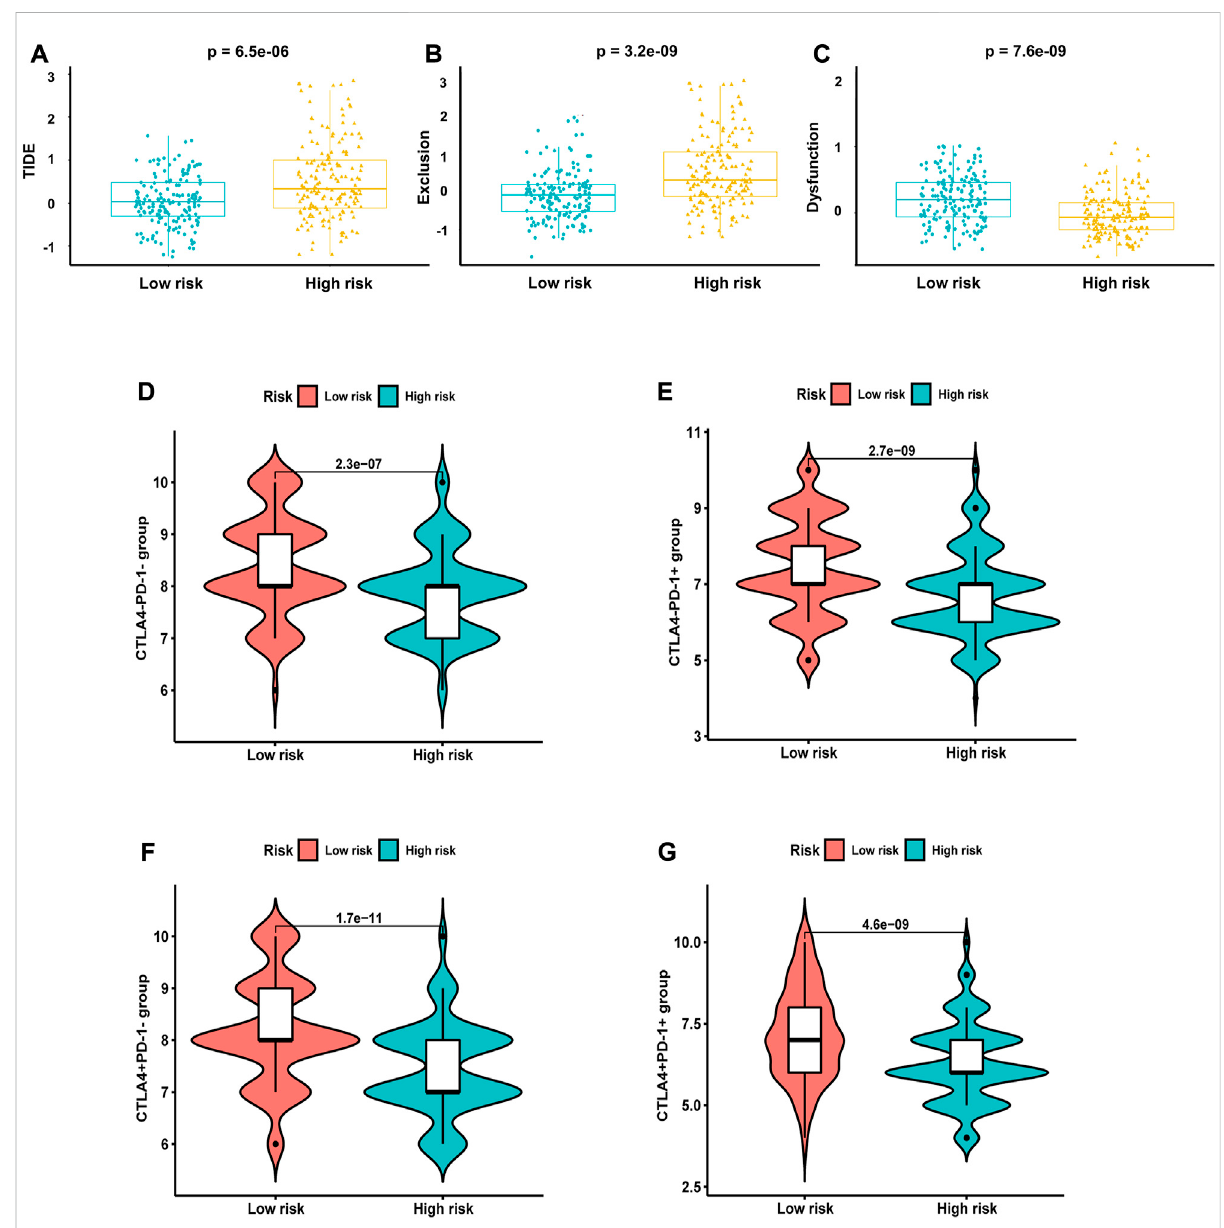
FIGURE 13 Responseofdifferentriskgroupstoimmunotherapy. (A) TIDEscore. (B) Exclusionscore. (C) Dysfunctionscore.ImmunophenoscorefromTICA including (D) CTLA4-PD-1- group, (E) CTLA4-PD-1+ group, (F) CTLA4+PD-1- group, and (G) CTLA4+PD-1+